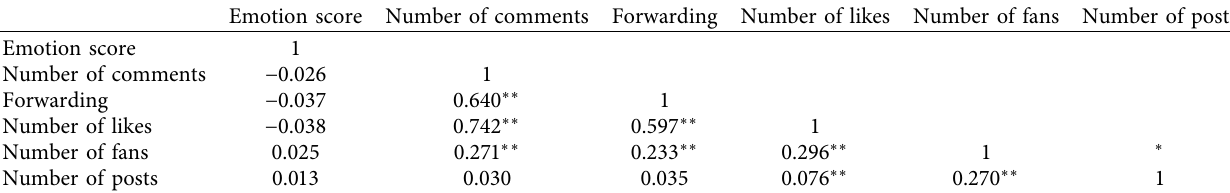
Table 4: Correlation analysis between antisocial emotion and the number of